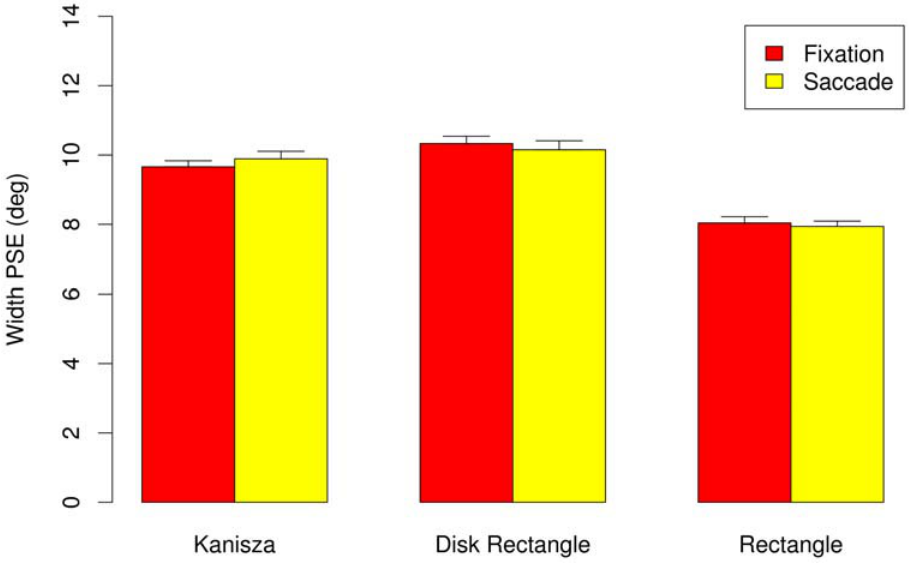
Figure 7. Experiment 1B: Perceived width (50% PSE thresholds) for the fixation and saccade conditions. Vertical bars indicate 95% within subject confidence intervals [17].